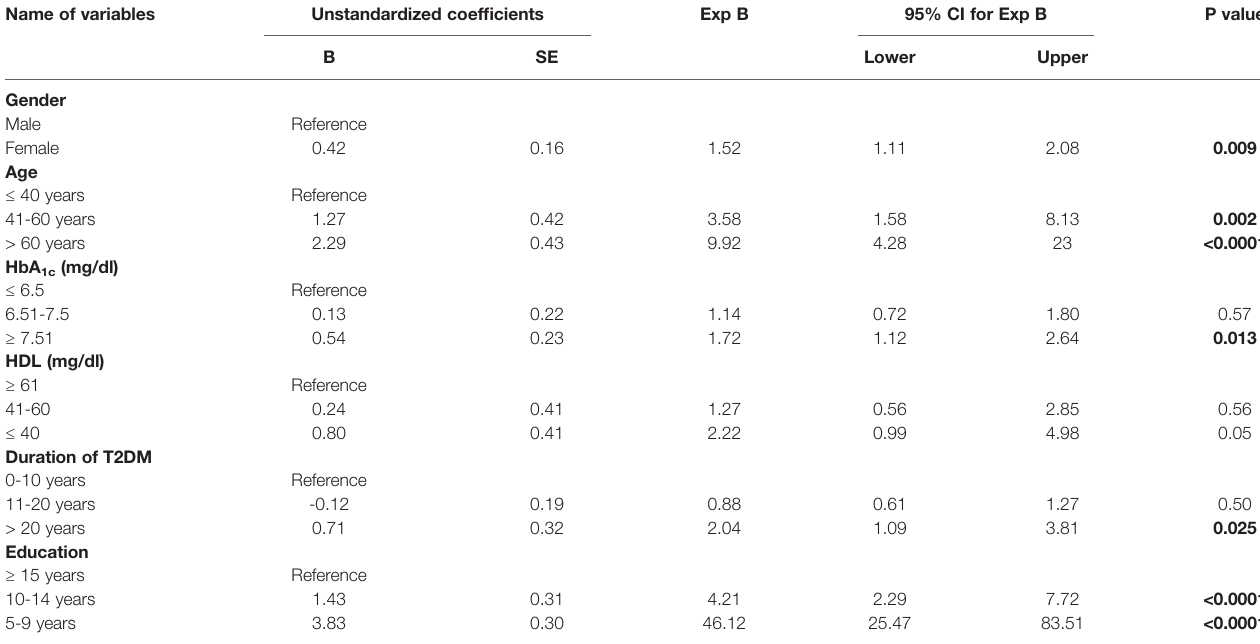
TABLE 3 | Binomial logistic regression analysis showing the factors related to mild cognitive impairment in T2DM patients (N=